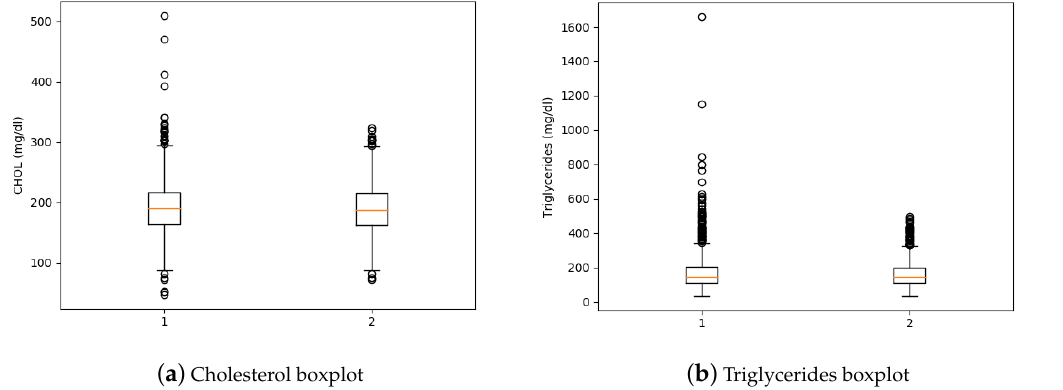
Figure 5. Cholesterol and Triglycerides